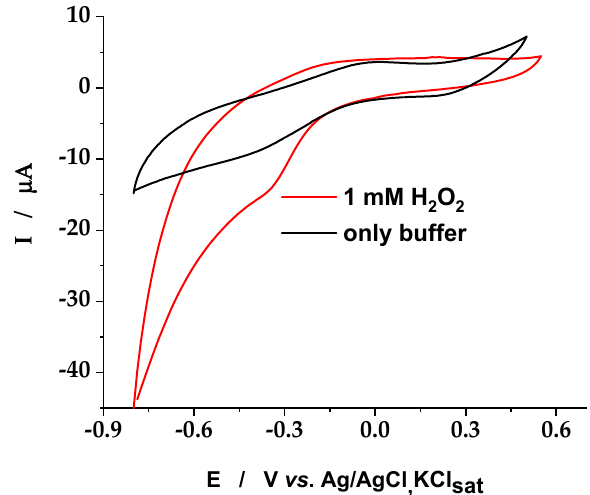
Figure 5. Cyclic voltammograms recorded in the absence and the presence of 1 mM H 2 O 2 at GC/Chi-CXBiFe 1.2 . Experimental conditions: scan rate, 20 mV s − 1 ; supporting electrolyte, 0.2 M phosphate buffer (pH 7); starting potential, − 0.8 V vs. Ag/AgCl, KCl sat.